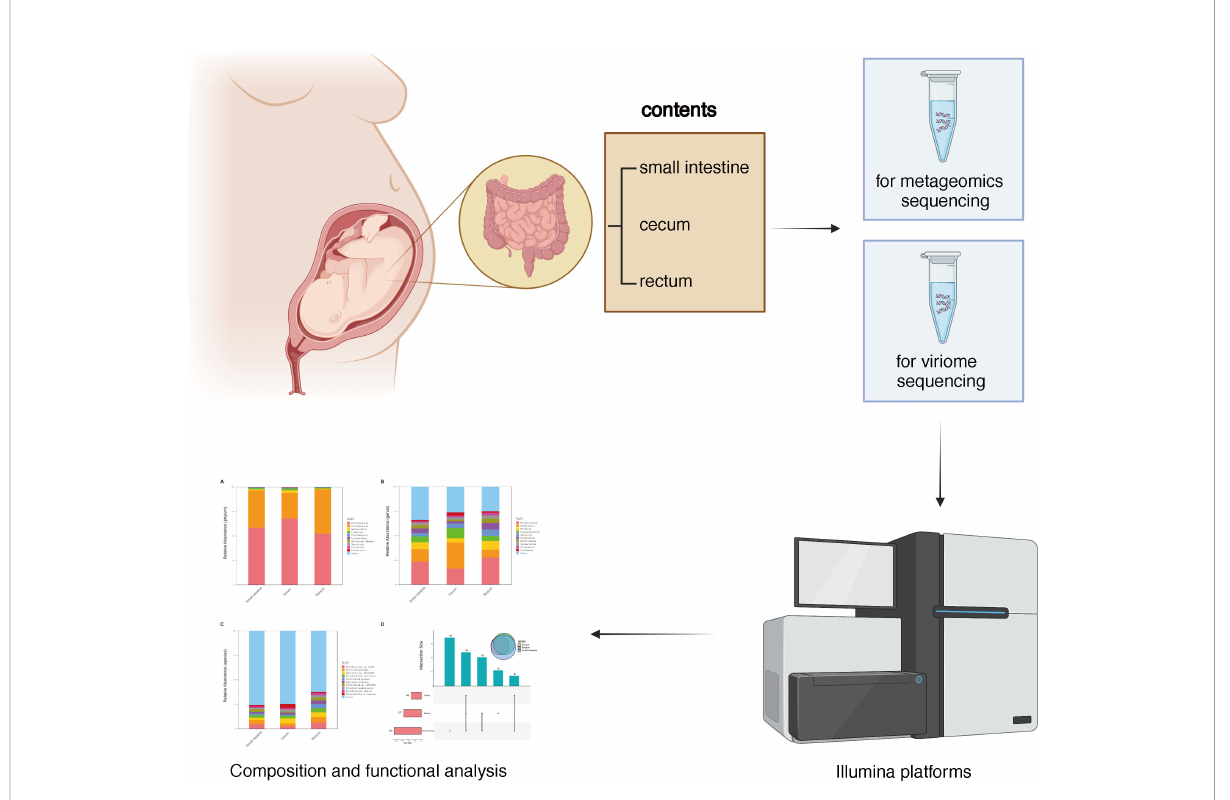
FIGURE 1 Graphical scheme and fl ow chart of experiment